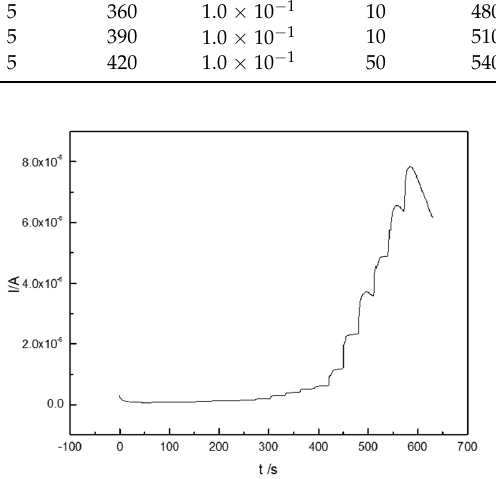
Figure 7. The chronoamperometric curve of the CTS-CAT/ β -CD-FE composite electrode.